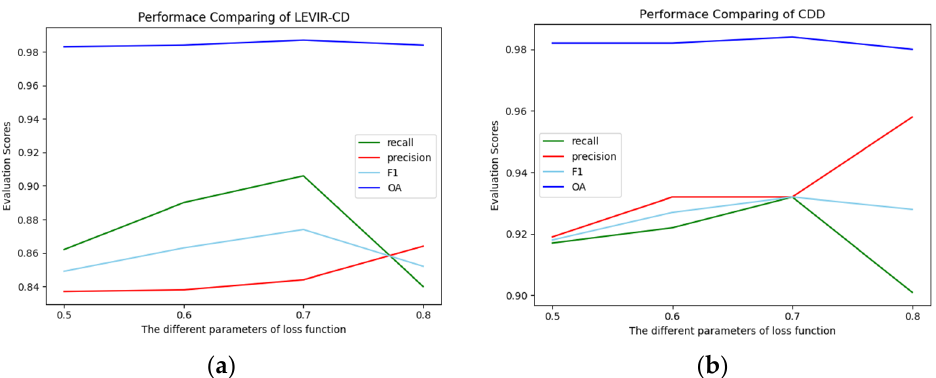
Figure 11. The influence of loss function parameters on the model: ( a ) experiment on the LEVIR-CD; ( b ) experiment on the CDD.